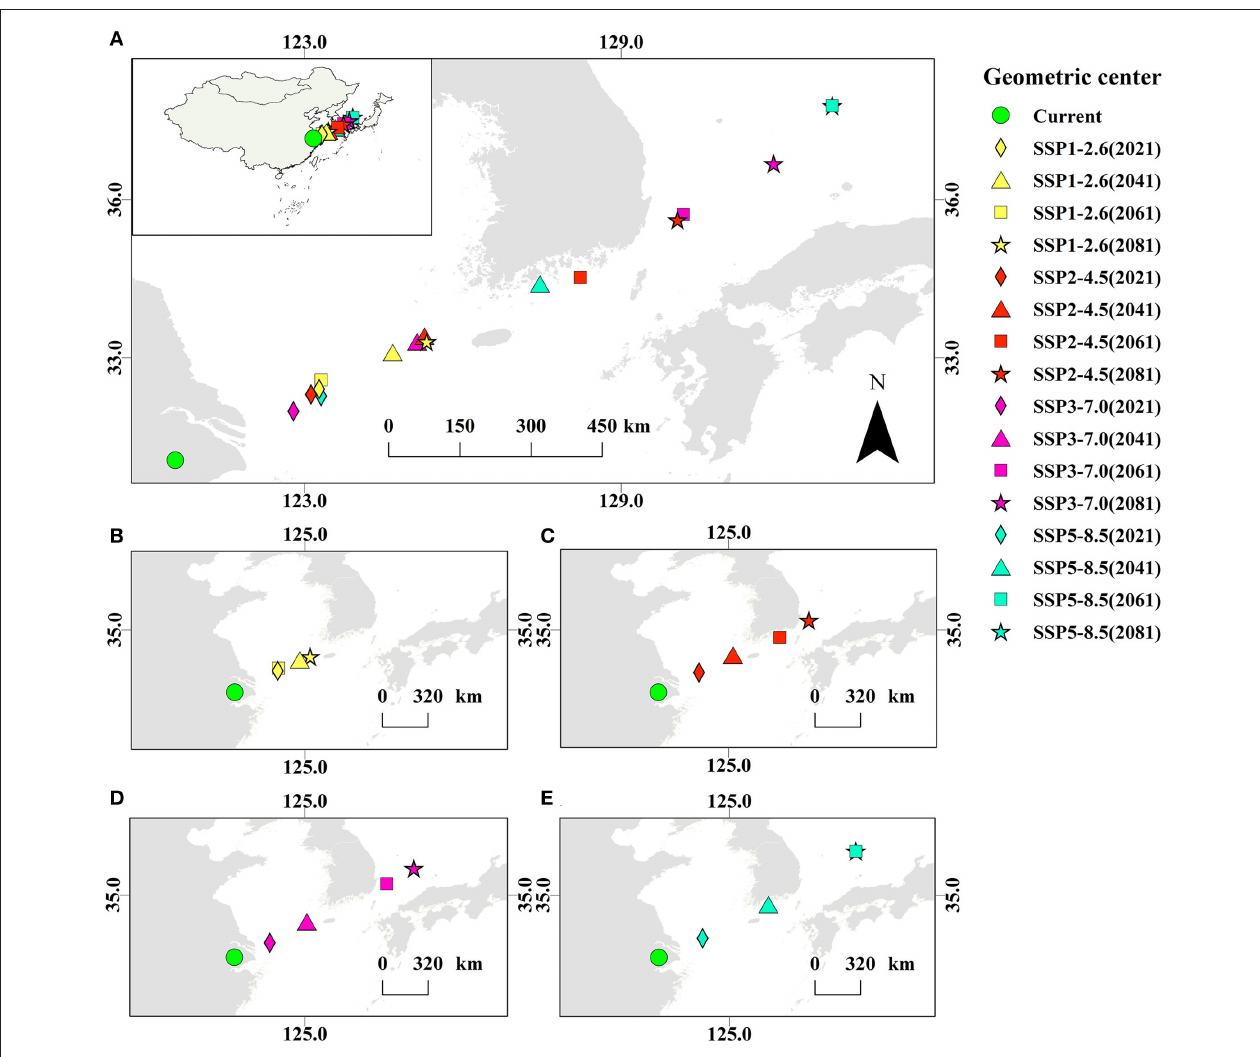
FIGURE 7 | Geometric centers of distribution regions of A. quinata . (A) Geometric centers in different climate scenarios. (B) Geometric centers in the SSP1-2.6 scenario. (C) Geometric centers in the SSP2-4.5 scenario. (D) Geometric centers in the SSP3-7.0 scenario. (E) Geometric centers in the SSP5-8.5